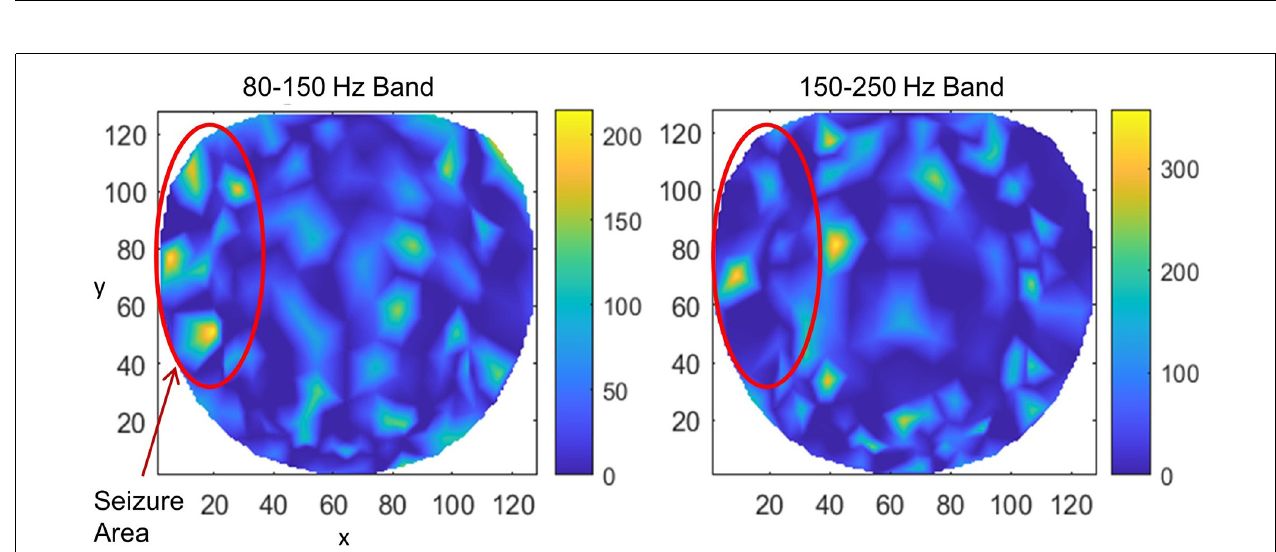
FIGURE 6 | The rate of formation (counts/s) of stable phase cone clusters averaged over a 240-s interictal period for subject #4 in the 80–150 and 150–250 Hz bands are given in the left and right plots, respectively. The color bar indicates the rate in counts/s. The epileptic spikes and seizure activity area is marked with a red ellipse. The left plot shows several hot spots in the left temporal frontal, central and parietal areas. The activity in the 150–250 Hz band, the right plot, has one hot spot in the left temporal central area and another hot spot at the right side of the red circle which could also be related to the silent interictal epileptic